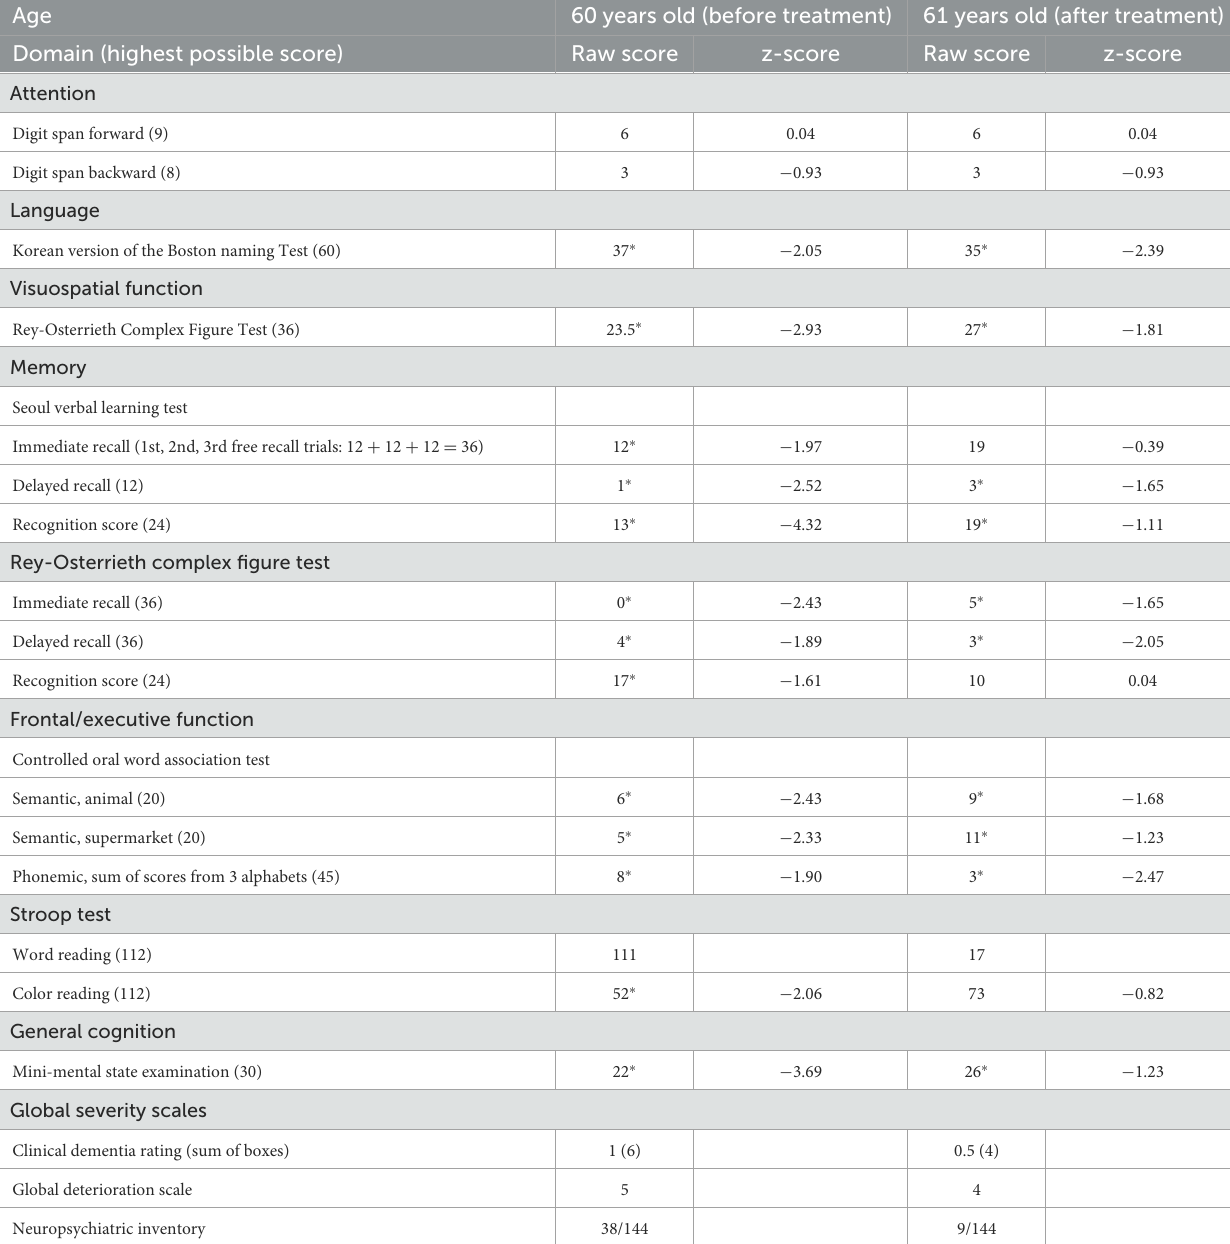
TABLE 1 The neuropsychological test results. Age 60 years old (before treatment) 61 years old (after treatment) Domain (highest possible score) Raw score z-score Raw score z-score